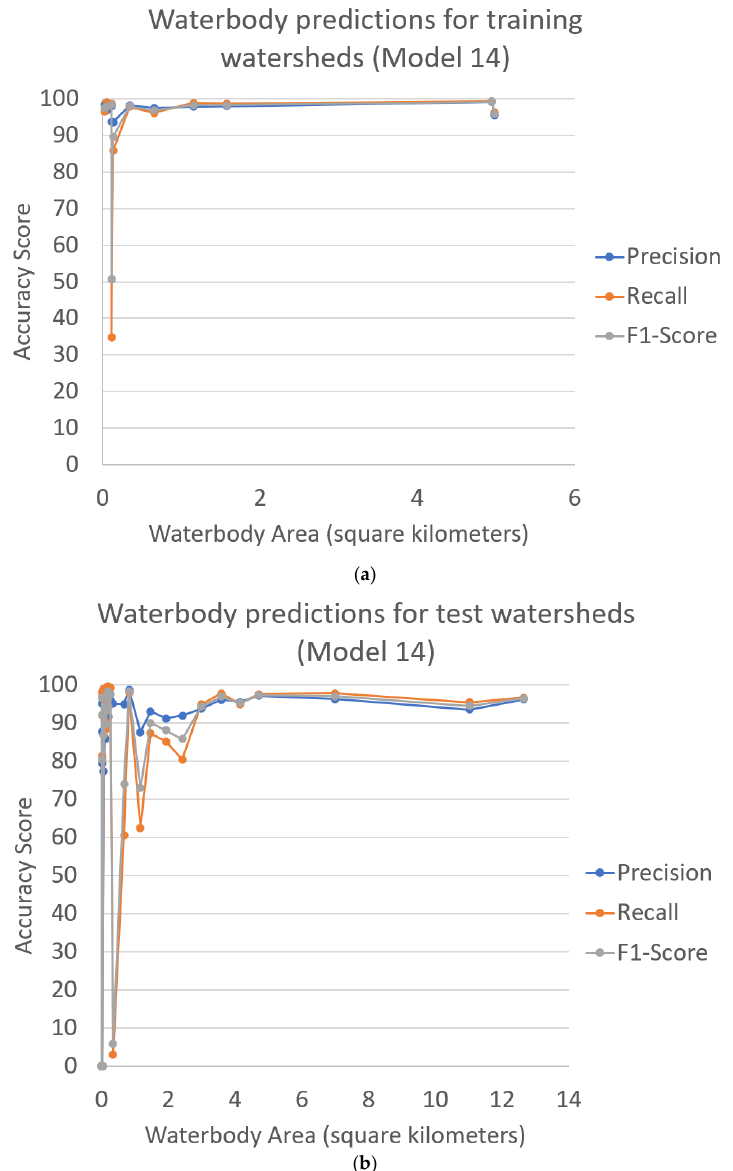
Figure 9. Accuracy scores (precision, recall, and F1-score) for predictions of waterbody features for ( a ) the 14 training HU12 watersheds and ( b ) the 36 test HU12 watersheds compared to total waterbody polygon area in reference hydrography. Predictions are determined from U-net model 14 using 14 HU12 training